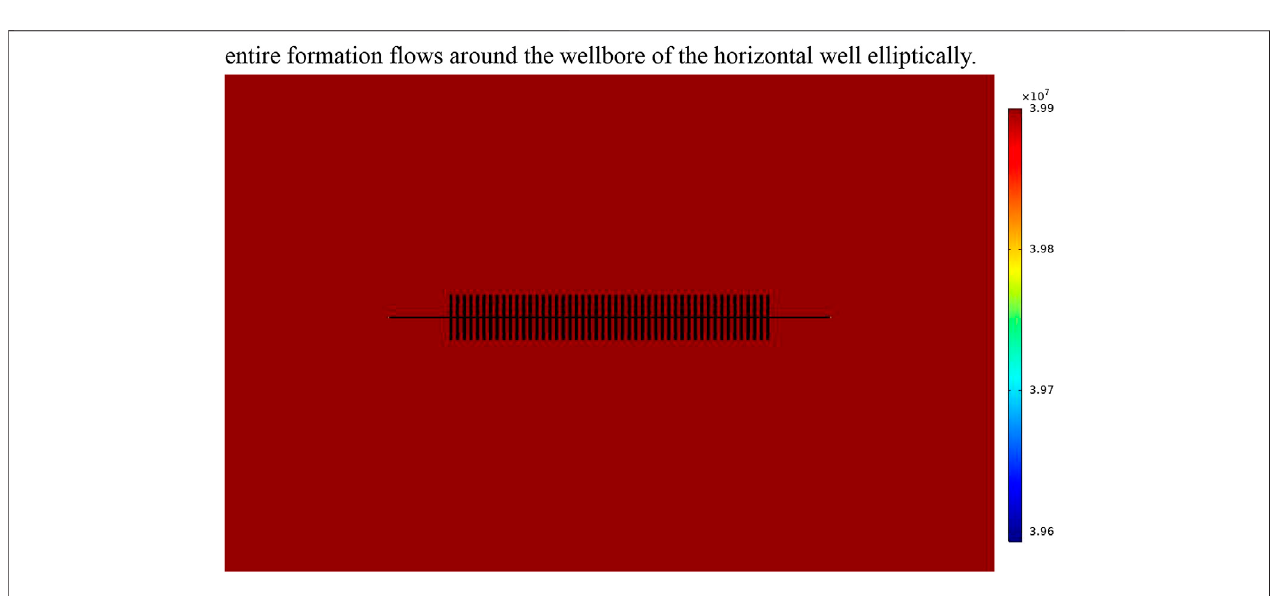
FIGURE 4 | Formation pressure distribution in volume fracturing horizontal well (0